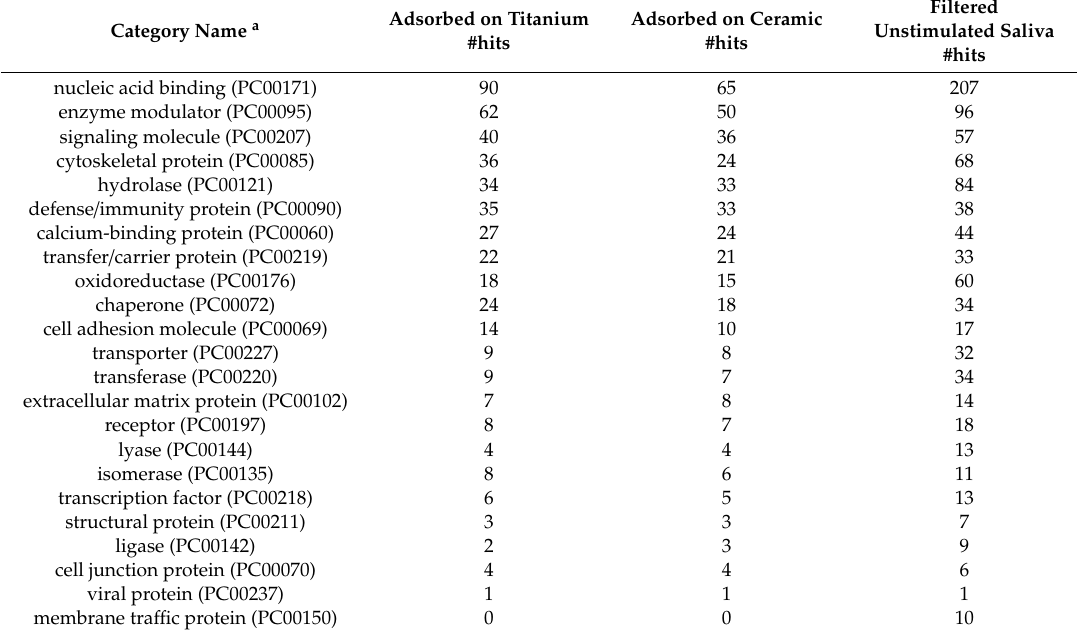
Table 2. Classification of detected